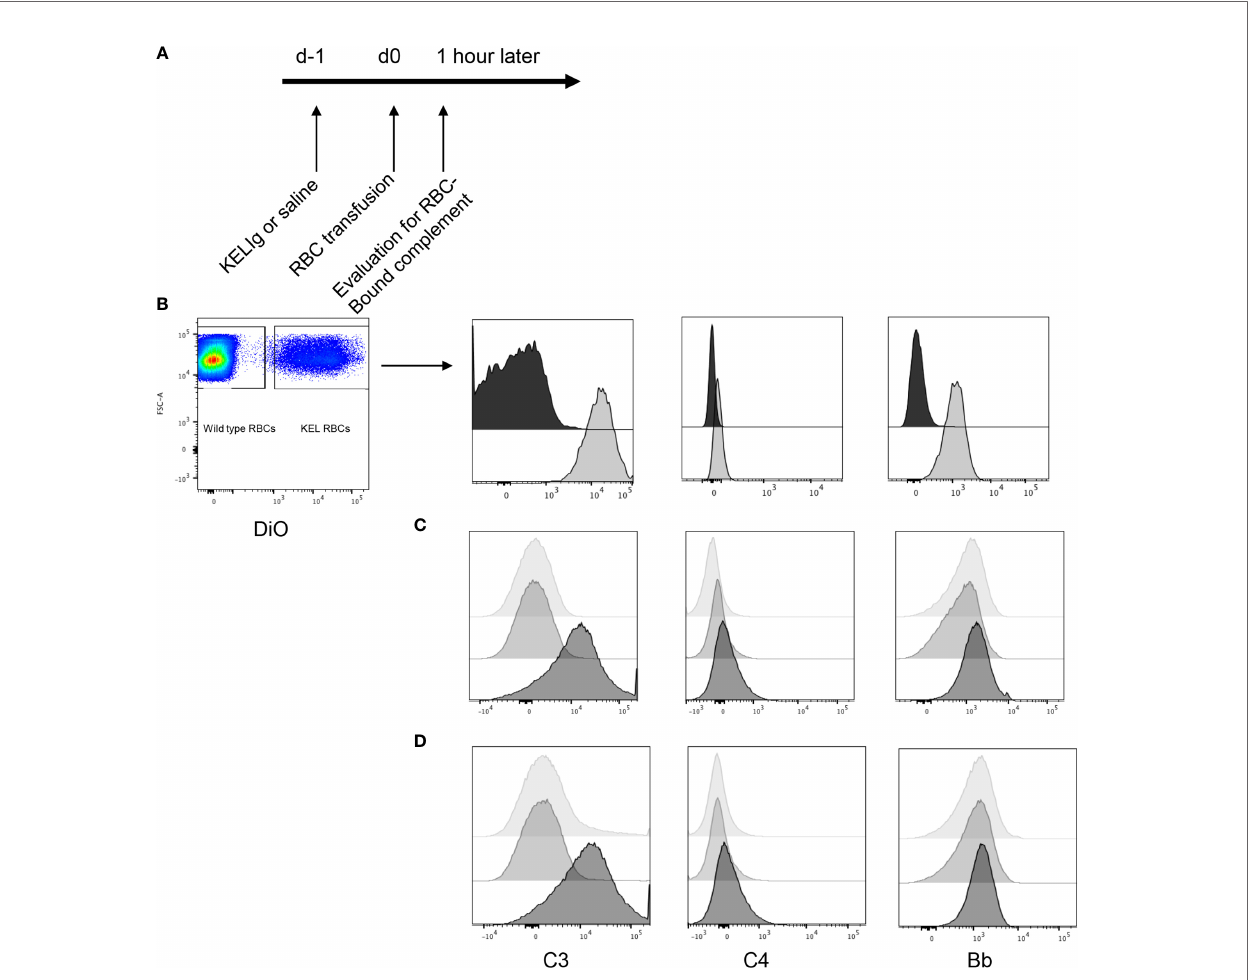
FIGURE 1 | Complement is fi xed on KEL RBCs in-vivo and in-vitro in response to polyclonal anti-KEL (KELIg). (A) General in-vivo experimental design: recipients were treated with or without KELIg and transfused with DiO labeled KEL RBCs. (B) C3, C4, and Factor B were measured on recovered DiO positive KEL RBCs 1-hour post-transfusion; black fi lled histogram shows condition without KELIg; grey shaded histogram shows condition with KELIg. (C) In-vitro experiments were completed with KELIg incubated with KEL RBCs in the presence (darkest histogram) or absence (lightest histogram) of serum; an additional condition included saline incubated with KEL RBCs in the presence of serum (medium grey histogram). (D) Additional in-vitro conditions included KELIg incubated with KEL RBCs in the presence of serum (darkest histogram), in the presence of serum with EGTA-Mg (lightest histogram) or serum with EDTA (medium grey histogram). These data are representative of 3 independent experiments; p < 0.05 for C3 detection on RBCs in the presence or absence of